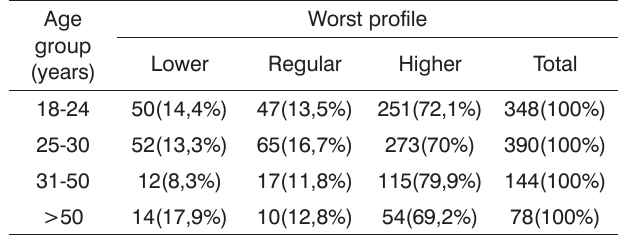
Table 4. Worst profile per age group of interviewees